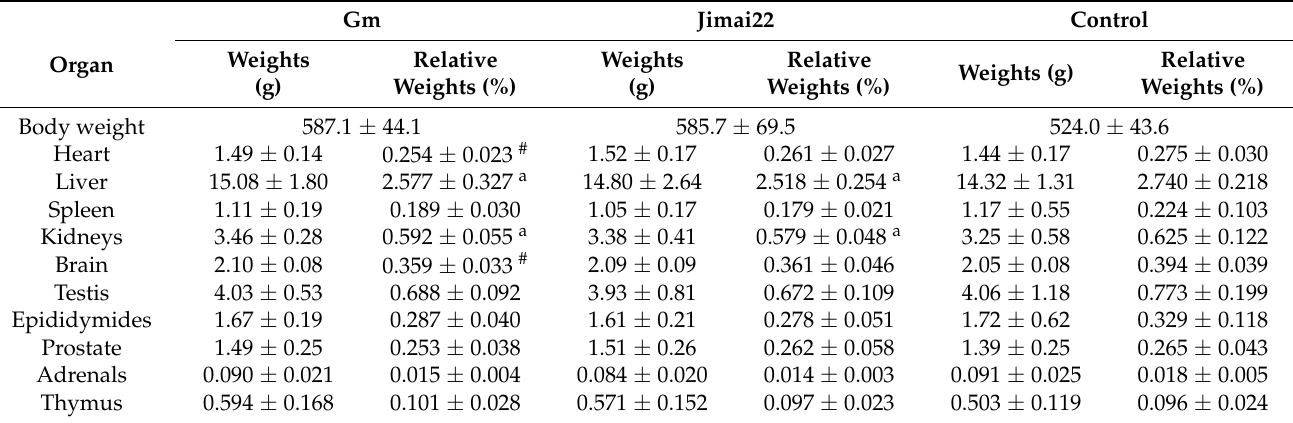
Table 4. Organ weights and relative organ weights of males ( x ± s, n =